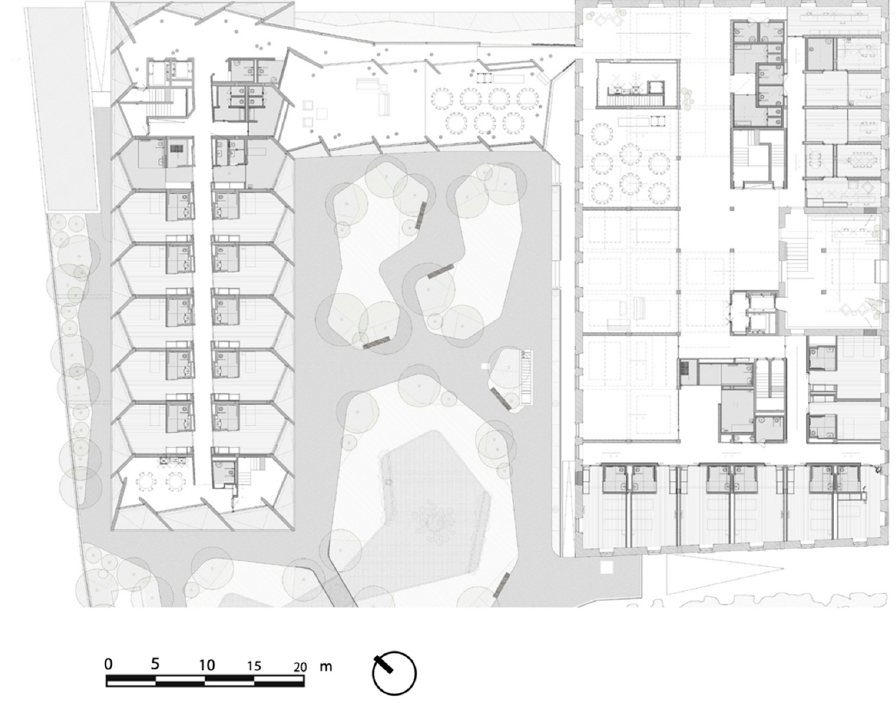
Figure 25. Coimbra. Ground-floor plan.